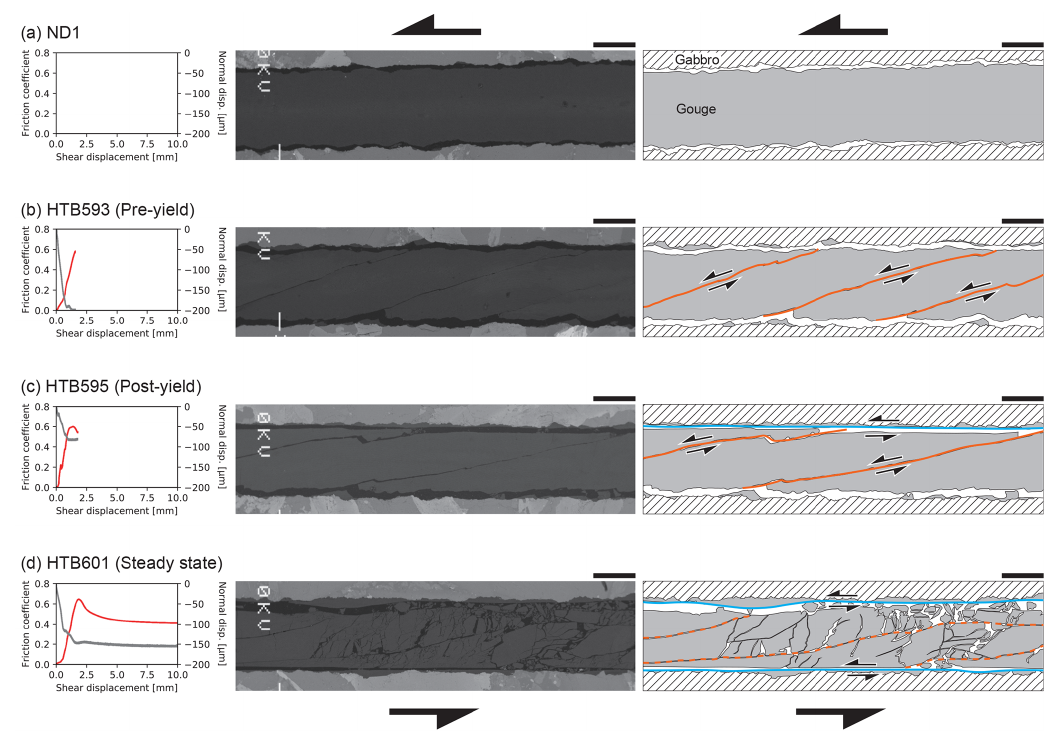
Figure 5. Backscattered electron (BSE) images showing the deformation of gouges (center) and corresponding interpretive sketches (right) of the dry experiments. The friction coefficients and normal displacement are shown in (a–d) using colored and gray lines. The orange lines, blue lines, gray area, hatched area, and white area in the sketches correspond to the Riedel shear, boundary shear, brucite gouge, gabbro block, and epoxy resin, respectively. The orange dotted lines are the Riedel shears, which may not be active. The arrows represent the slip directions. The scale bars represent 200µm.